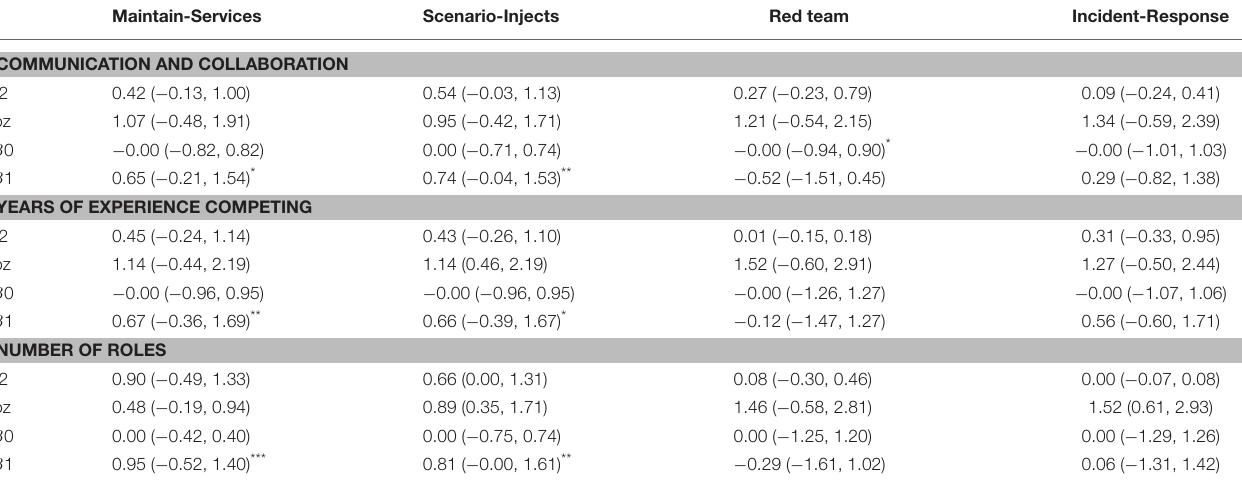
TABLE 2 | Means of posterior distribution (and 95% highest posterior density intervals) for each of the simple regression parameters. Maintain-Services